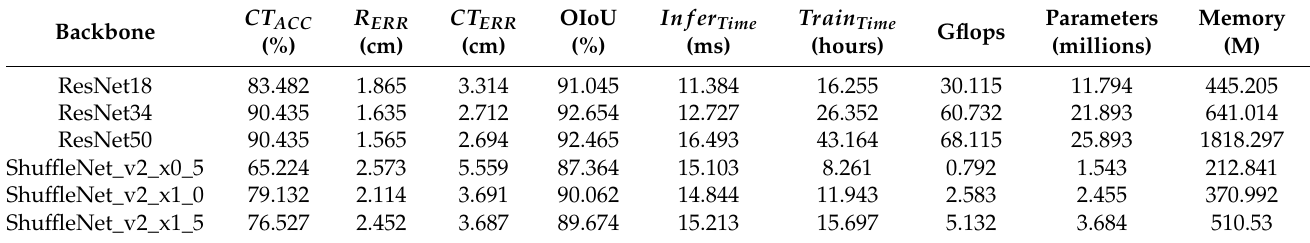
Table 3. The effect of applying different backbone networks to the model.